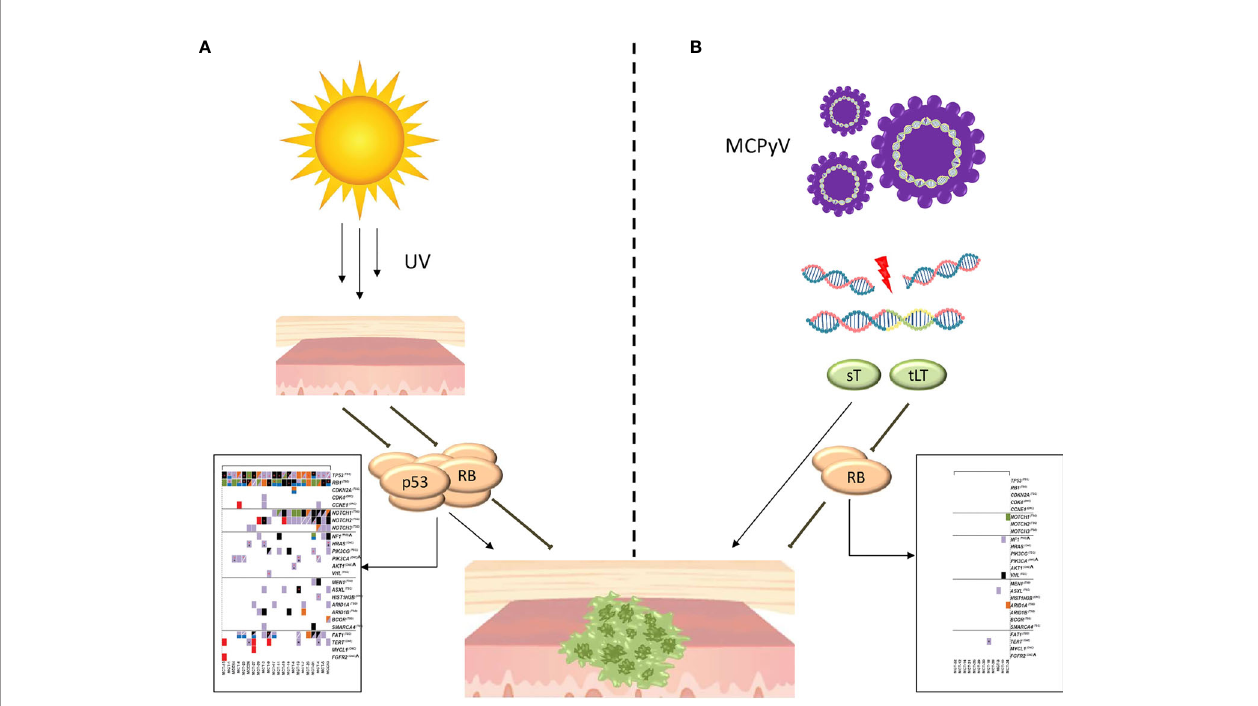
FIGURE 1 | Pathogenesis of MCC. (A) Pathogenesis of UV-induced MCC. The progressive DNA damage induced by UV leads to the accumulation of a large number of mutations, largely included in the so-called UV signature, with the most common in p53 and Rb. In the box (29) are reported cancer genes affected by mutation or copy number alterations in UV-induced MCC. (B) Pathogenesis of virus-induced MCC. The mutated viral genome is integrated into the host genome, with the expression of two neoantigens: small T (sT) and truncated large T (tLT). The TLT antigen binds to and inactivates Rb while sT antigen inhibits the proteasomal degradation. In the box (29) are reported cancer genes affected by mutation or copy number alterations in virus-induced